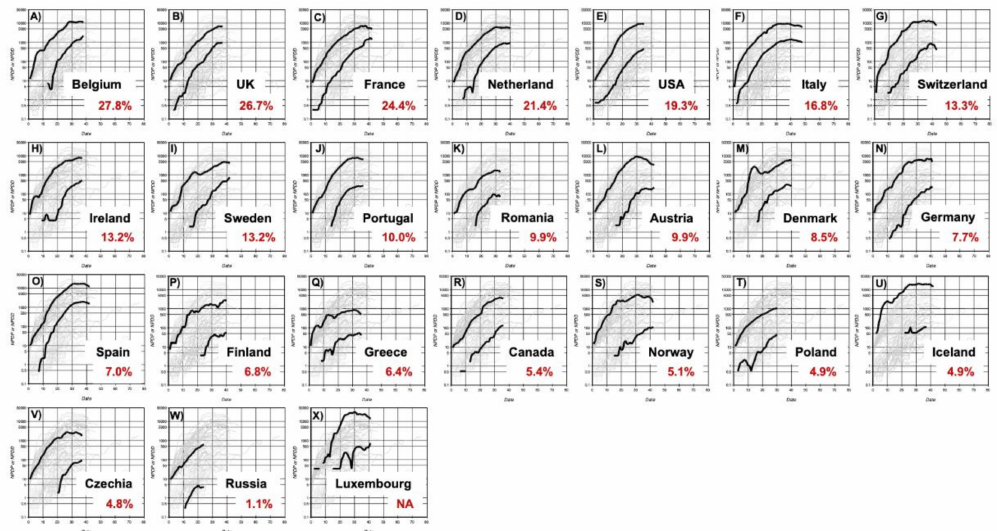
Figure 3. Time courses of NPDP and NPDD after BPI by COVID-19 in countries in Europe and North America (Panels ( A – X) ). Numbers in red represent the positive rate of the PCR test. The countries are placed in decreasing order of positive rate. The upper and lower bold lines in each panel are NPDP and NPDD, respectively. The scales in all panels are the same as those in Figure 1. NA: Not available. NPDP: number of population-adjusted daily test-positive cases. NPDD: number of population-adjusted daily deaths. BPI: beginning of the test-positive cases